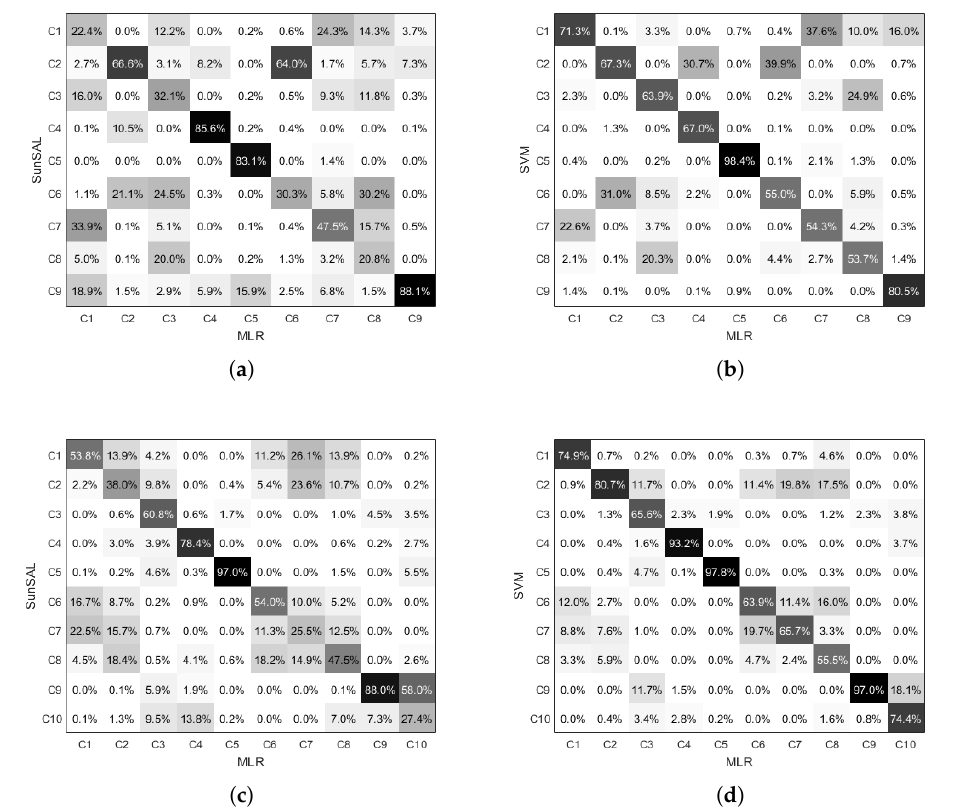
Figure 6. Confusion matrices between ( a ) SunSAL and the MLR classifier on the University of Pavia image; ( b ) the SVM and the MLR classifier on the University of Pavia image; ( c ) SunSAL and the MLR classifier on the Indian Pines image; ( d ) the SVM and the MLR classifier on the Indian Pines